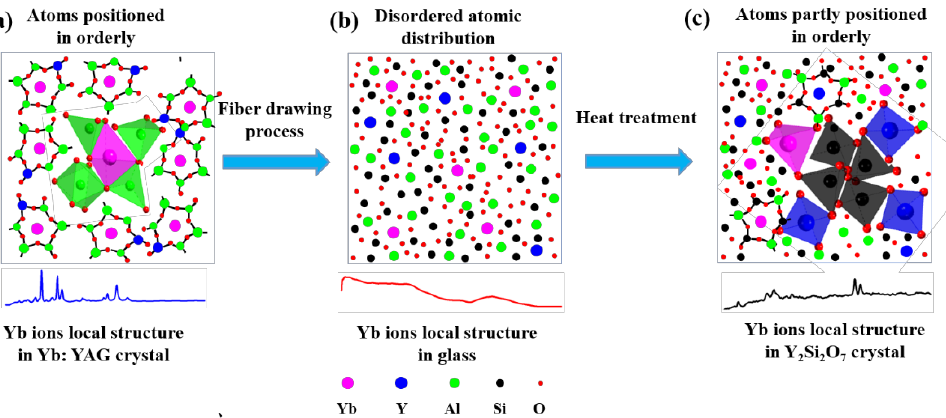
Figure 6. Schematic illustration of the local environments around Yb ions in ( a ) Yb: YAG crystal, ( b ) glass, and ( c ) Y 2 Si 2 O 7 crystal.